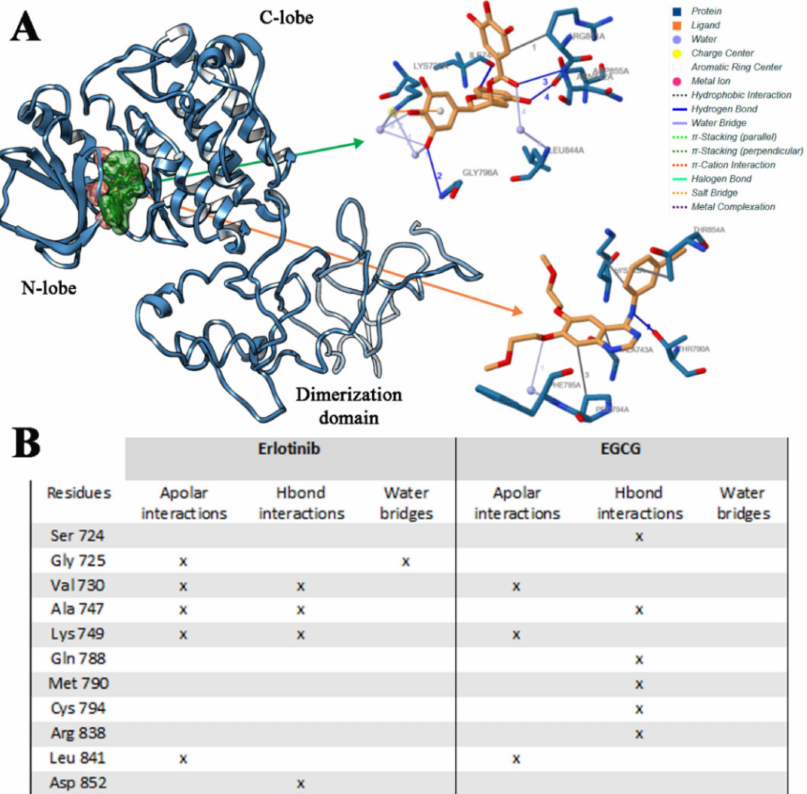
Figure 7. Binding mode of Erlotinib and EGCG in association with wild type EGFR domain ( A ), and interactions list of Erlotinib and EGCG with wild type EGFR ( B ). The 3D binding mode of Erlotinib (orange) and EGCG (green) has been